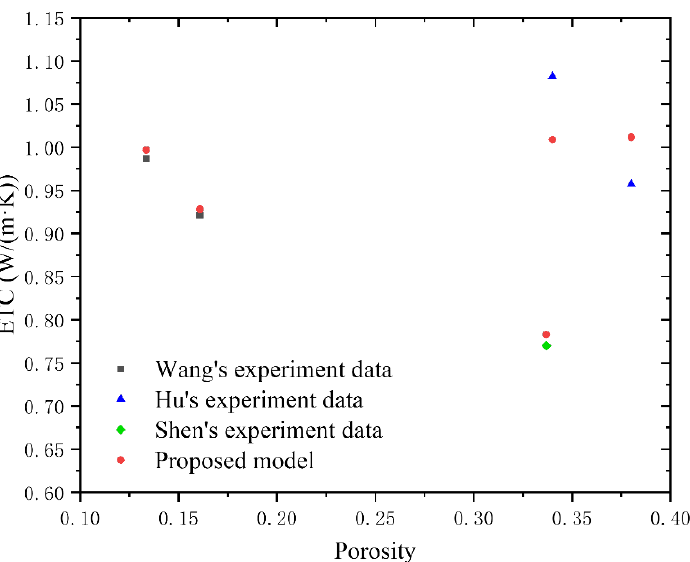
Figure 5. The calculated results are compared with the experimental data of Wang [12], Shen [29] and Hu